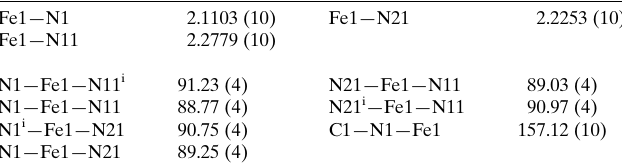
Table 2 Selected geometric parameters (A˚ , (cid:2) ) for 2 .